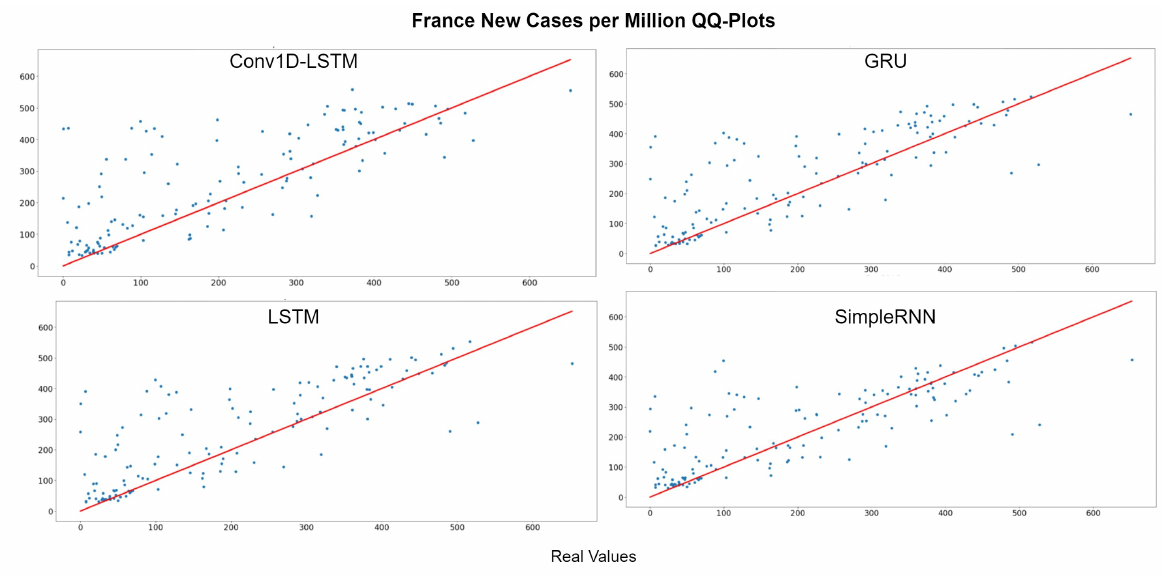
Figure 7. France new cases per million QQ-Plot for each